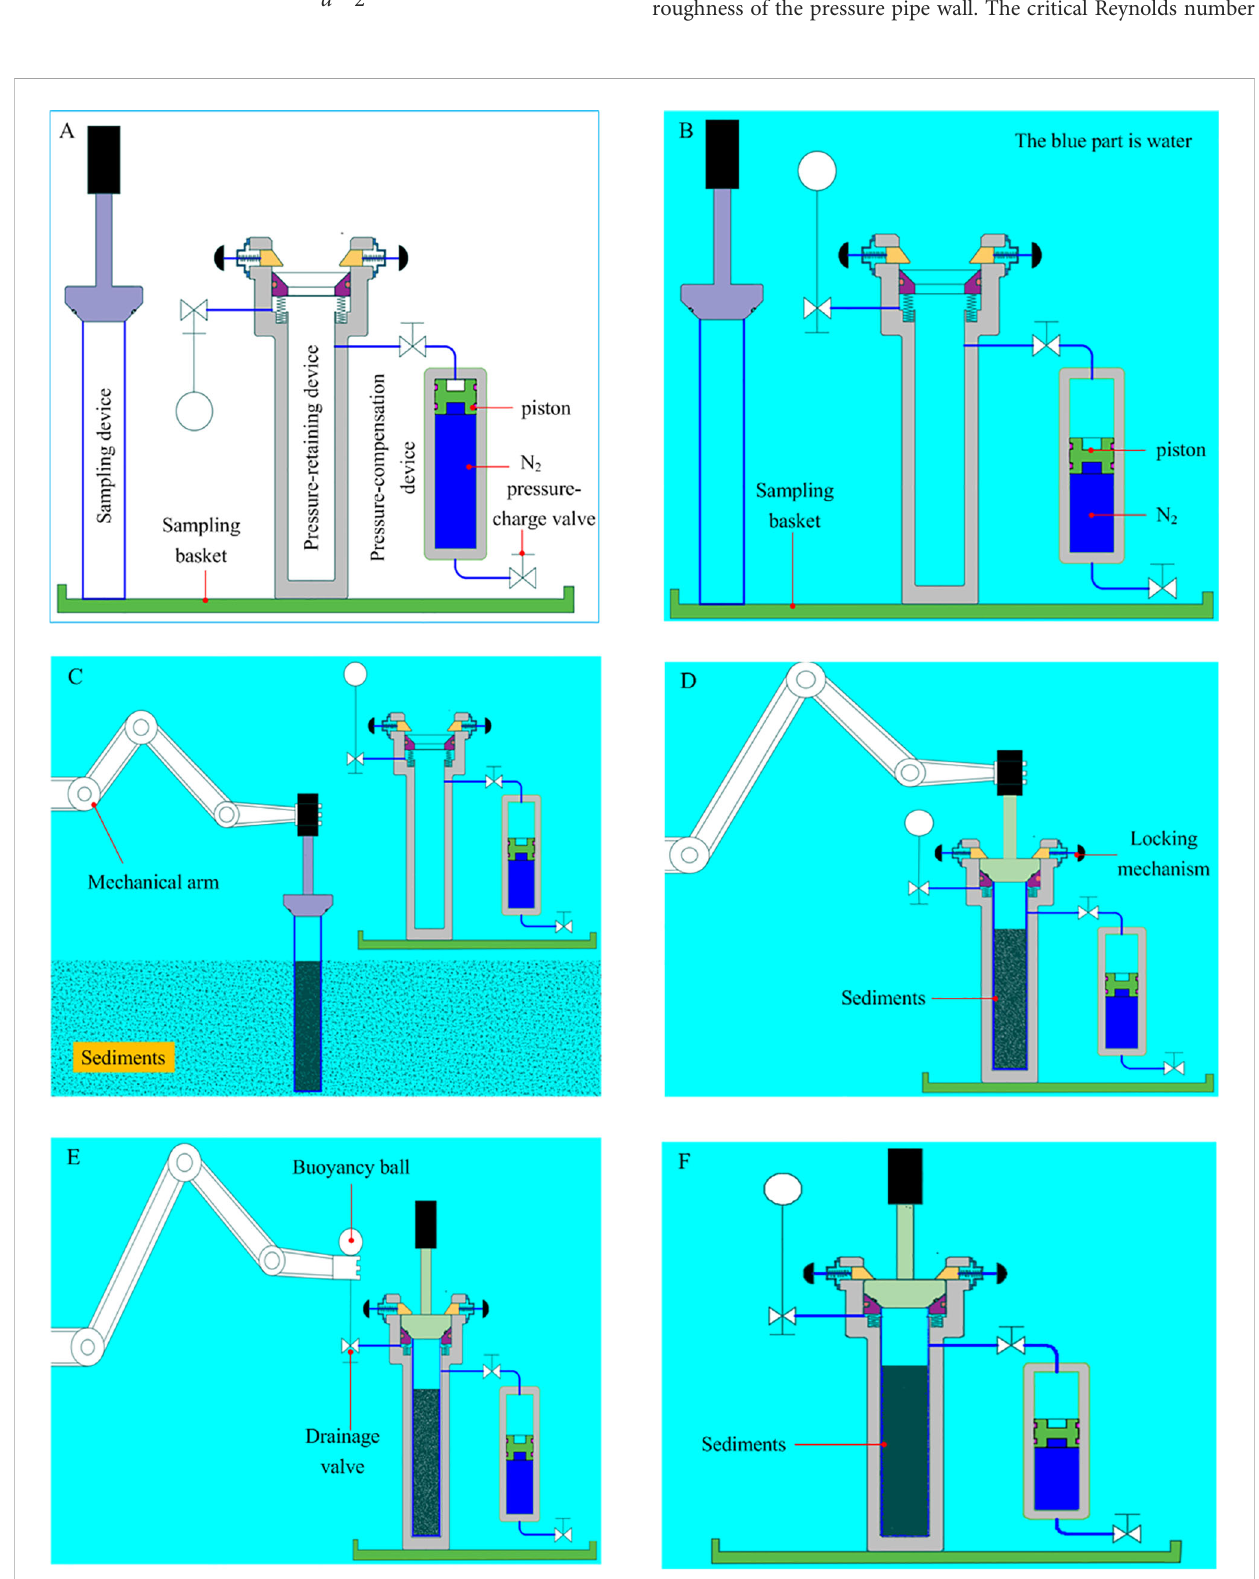
FIGURE 5 Working principle. (A) preparation stage of the sampler before diving, (B) the sampler dives with the submersible, (C) sampling at the sampling site, (D) sampling unit is locked after sampling, (E) drain valve is closed, and (F) recovery stage of the